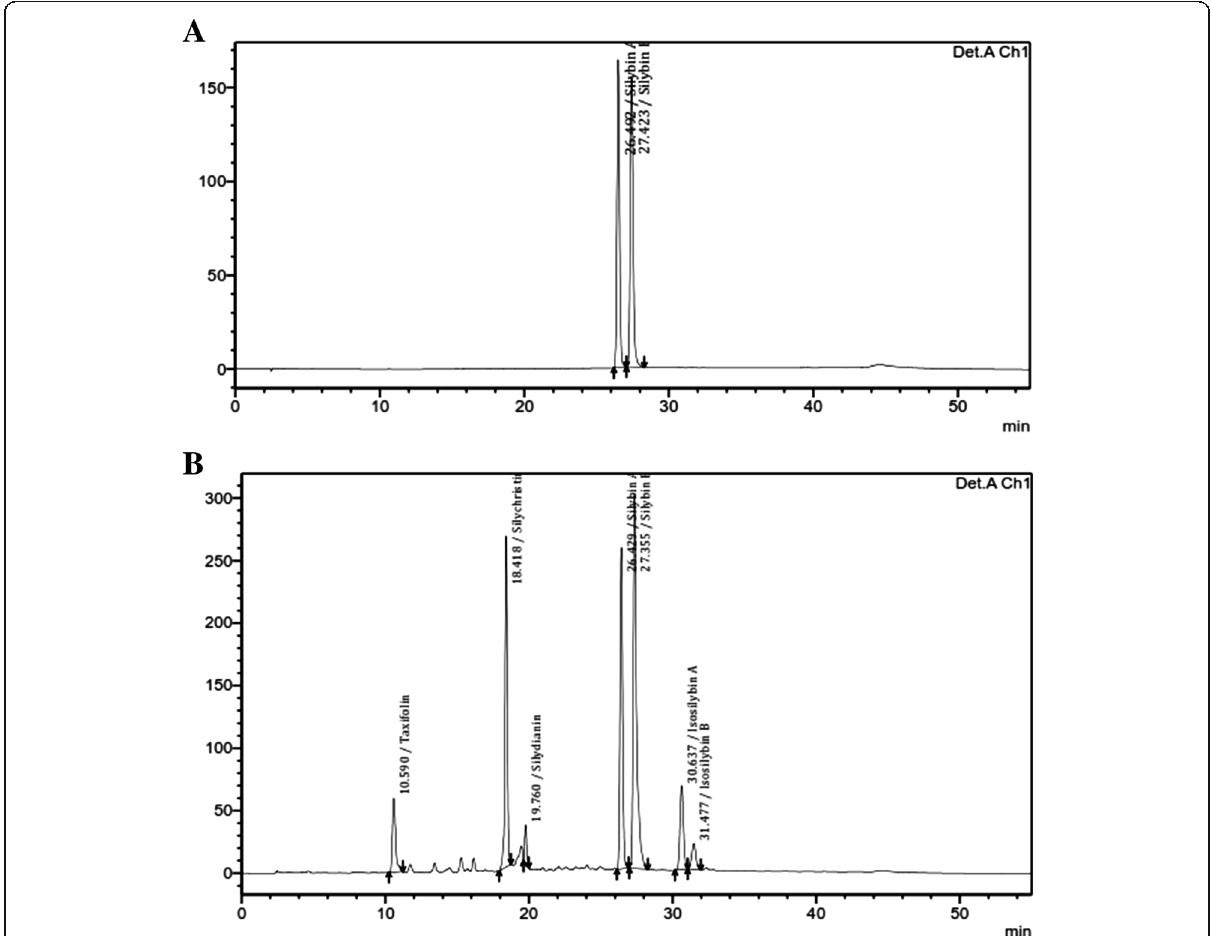
Fig. 1 HPLC chromatogram of ( a ) Silibinin (98%) and ( b )